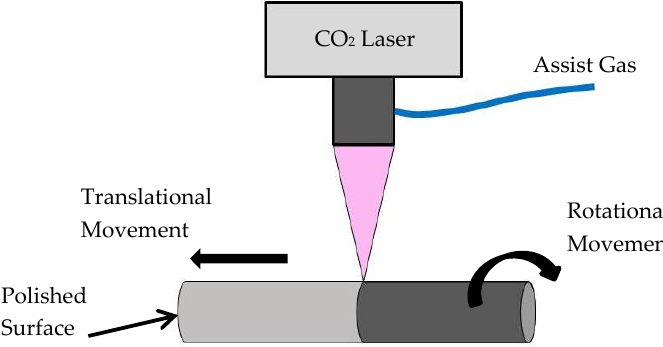
Figure 1. Schematic diagram for the CO 2 laser polishing scan process of additive manufacturing (AM) produced stainless steel 316L cylindrical samples.